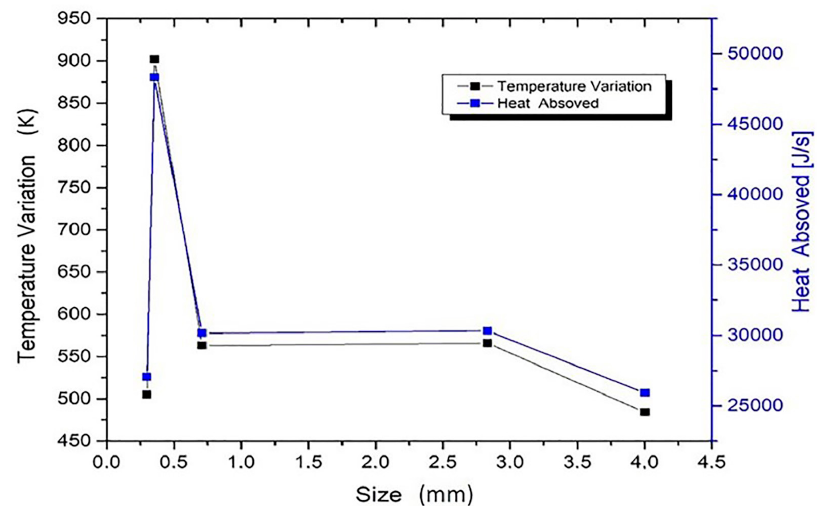
Figure 10. Heating rate and amount of energy absorbed by iron ore particles in the range of 0 to 3 minutes for different mean particle